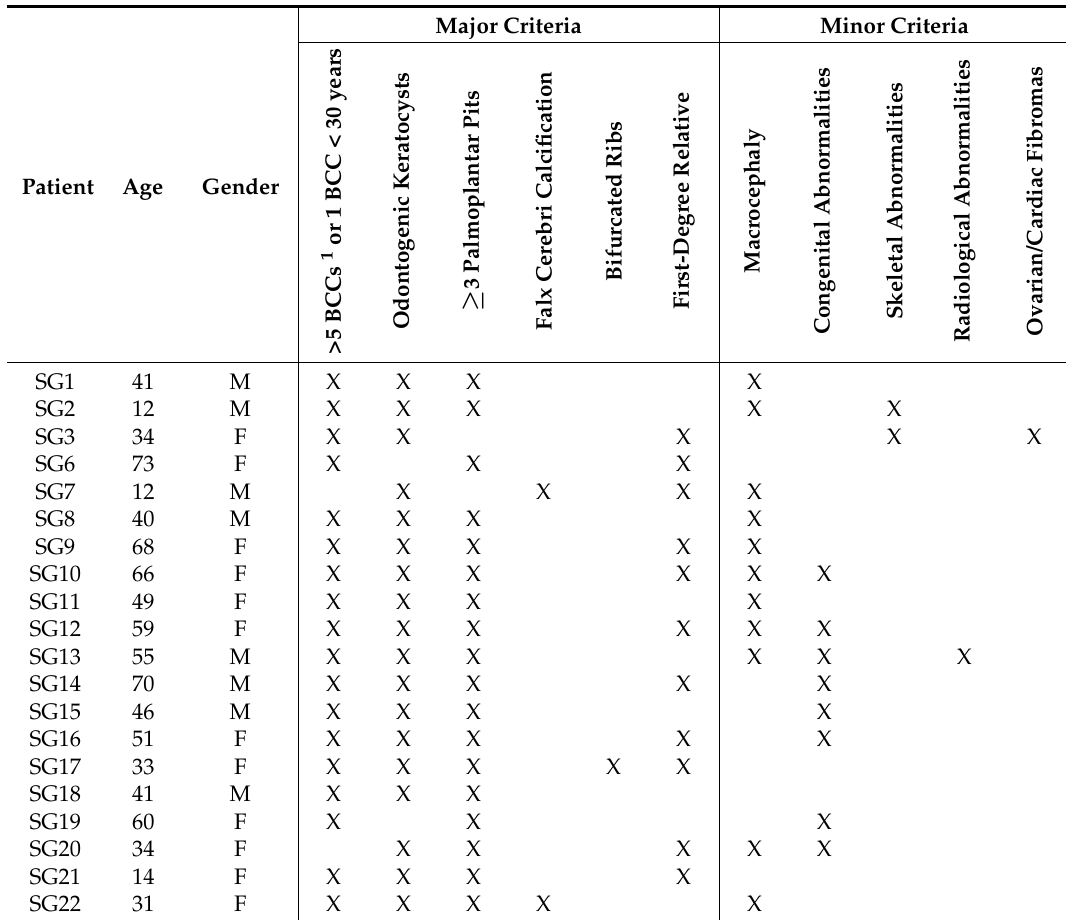
Table 1. Attributes found in nevoid basal cell carcinoma syndrome probands